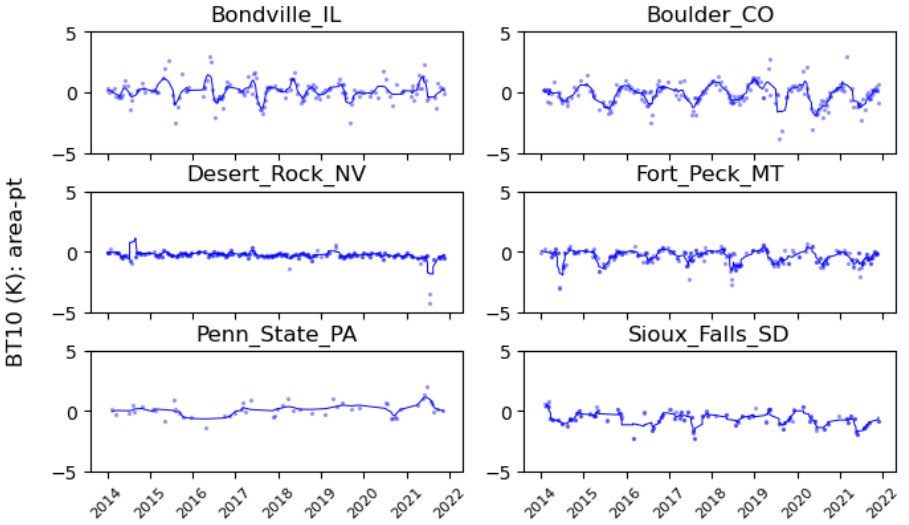
Figure 12. The heterogeneity analysis of SURFRAD stations over brightness temperature variable. Pronounced seasonal variations are observed over the TBL, FPK, and BON stations, and a weak variation is observed over the SXF station. Over the DRA site, however, the interannual curve is very straight with very small fluctuations over the years. The scale difference over the PSU station is also flat but with more fluctuations than the DRA site.